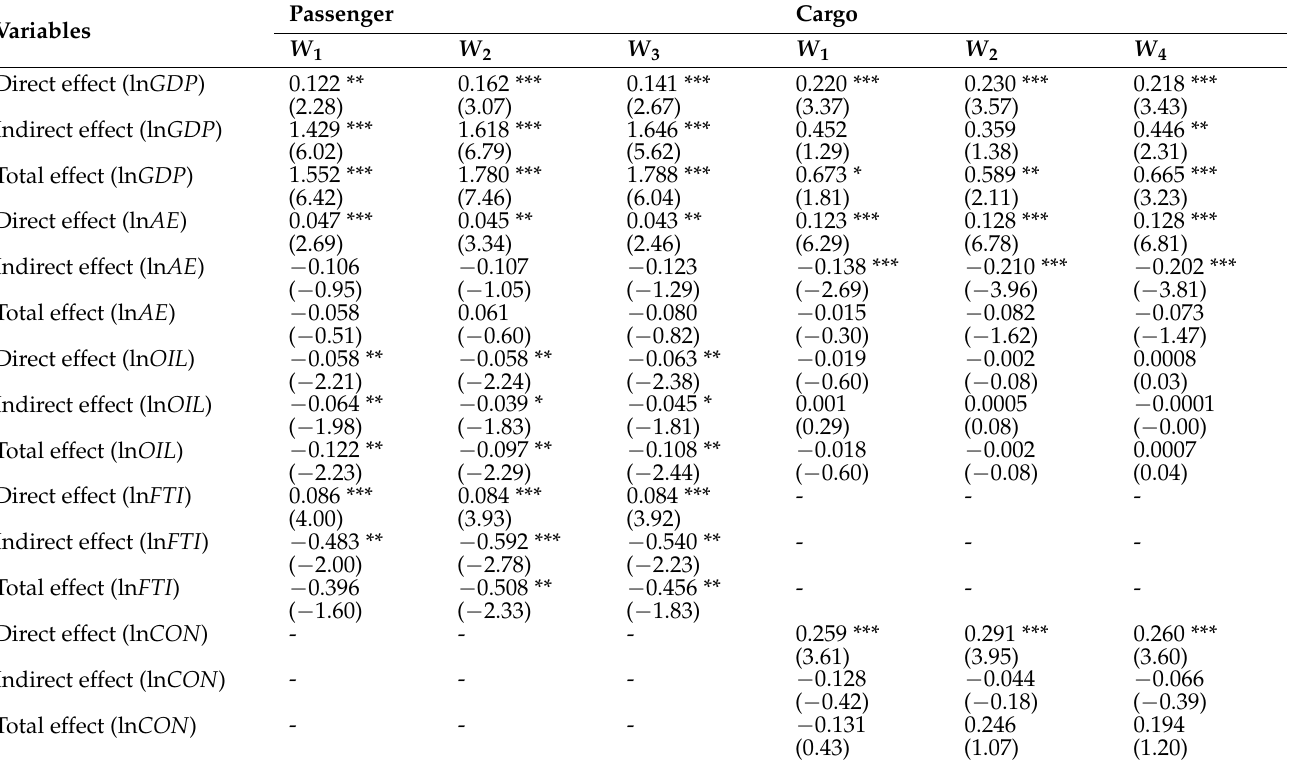
Table 5. Estimated direct and spillover effects on airport passenger and cargo